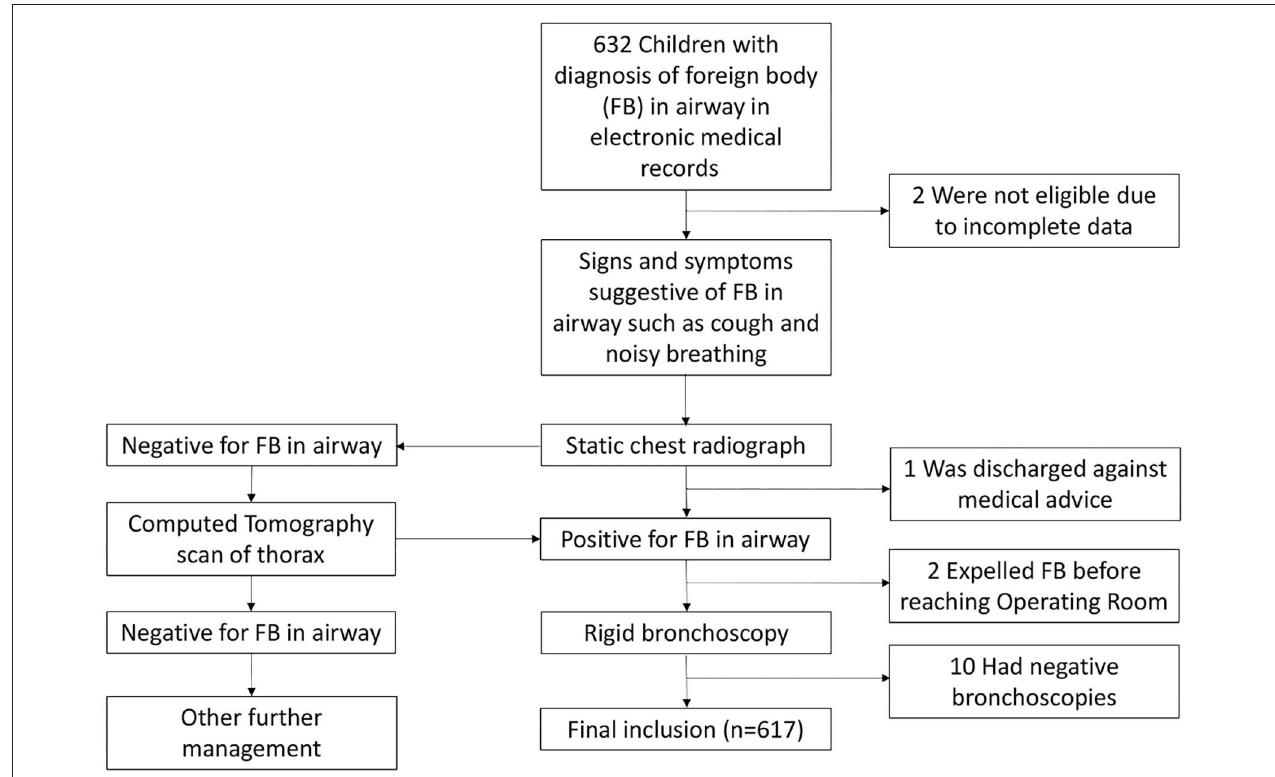
FIGURE 1 | Flowchart showing methods of patient collection and management in this study. The clinical and operative records of 632 children with airway foreign body (FB) treated in Kunming Children’s Hospital, China from February 2016 to June 2019 were retrieved and reviewed. The common signs and symptoms suggestive of FB in airway were analyzed, together with the standard of diagnosis and management of the patients.